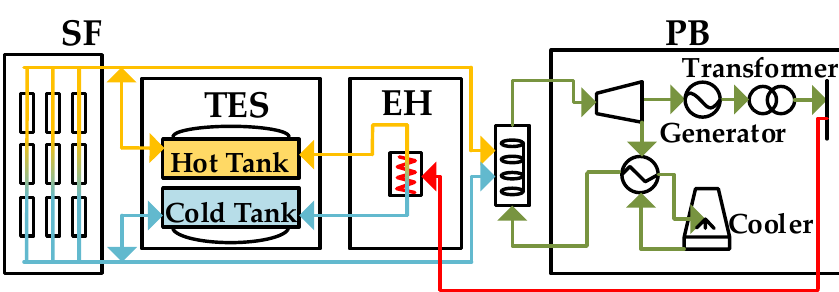
Figure 1. Configuration of a two-tank concentrating solar power (CSP) station with electrical heater (EH) equipment.